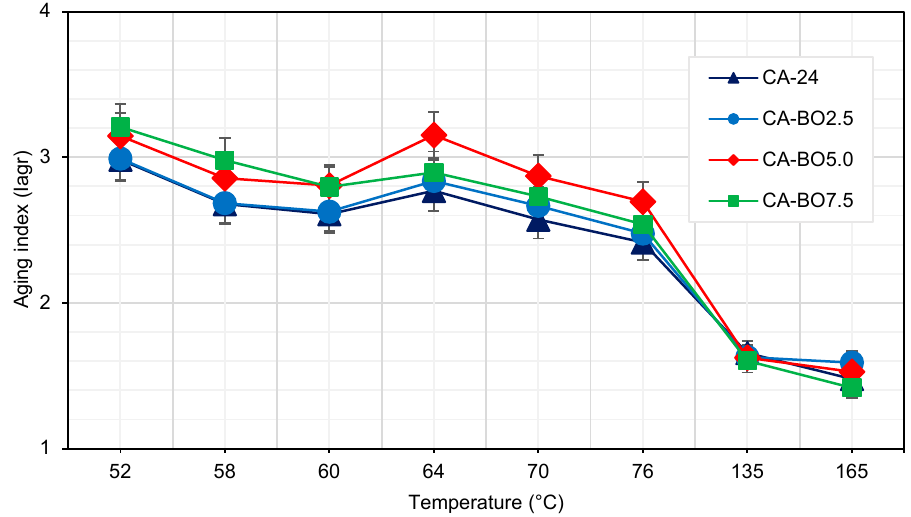
Figure 9. Aging index (I agr ) of the samples.